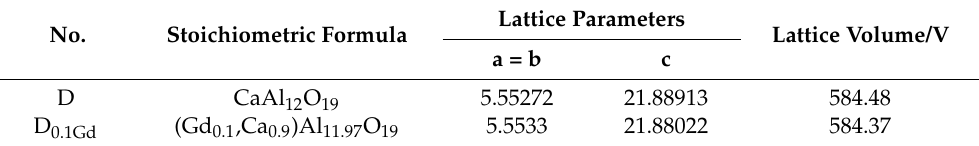
Table 2. Lattice parameters of Sample D and D 0.1Gd.